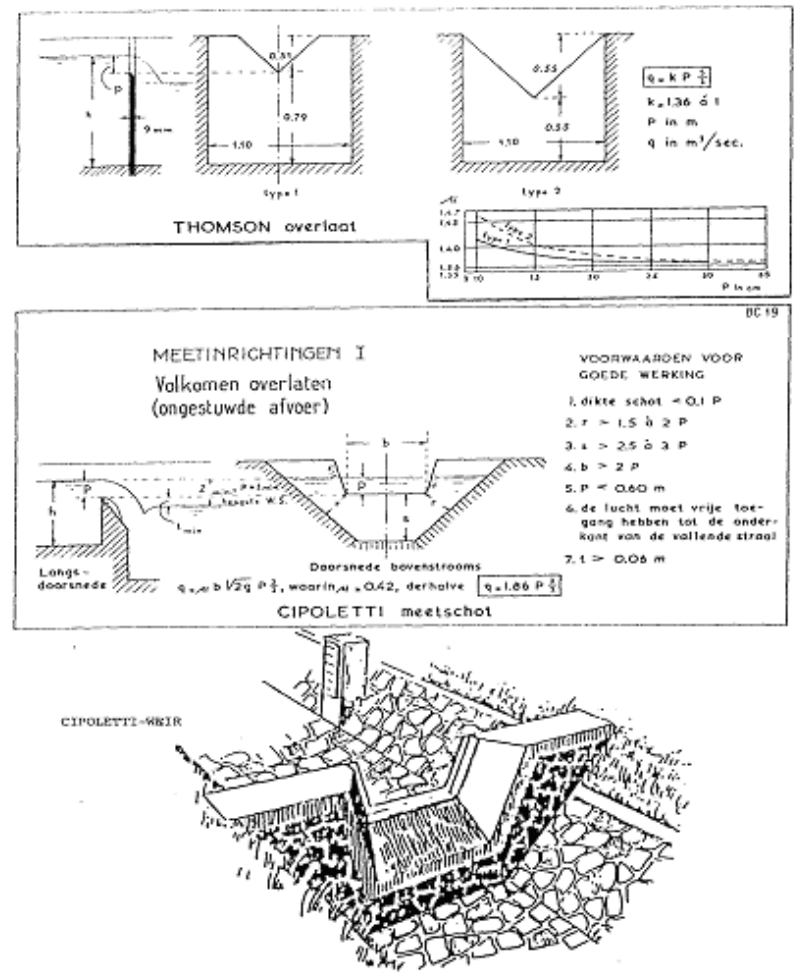
Figure 3 Cipoletti and Thomson structures